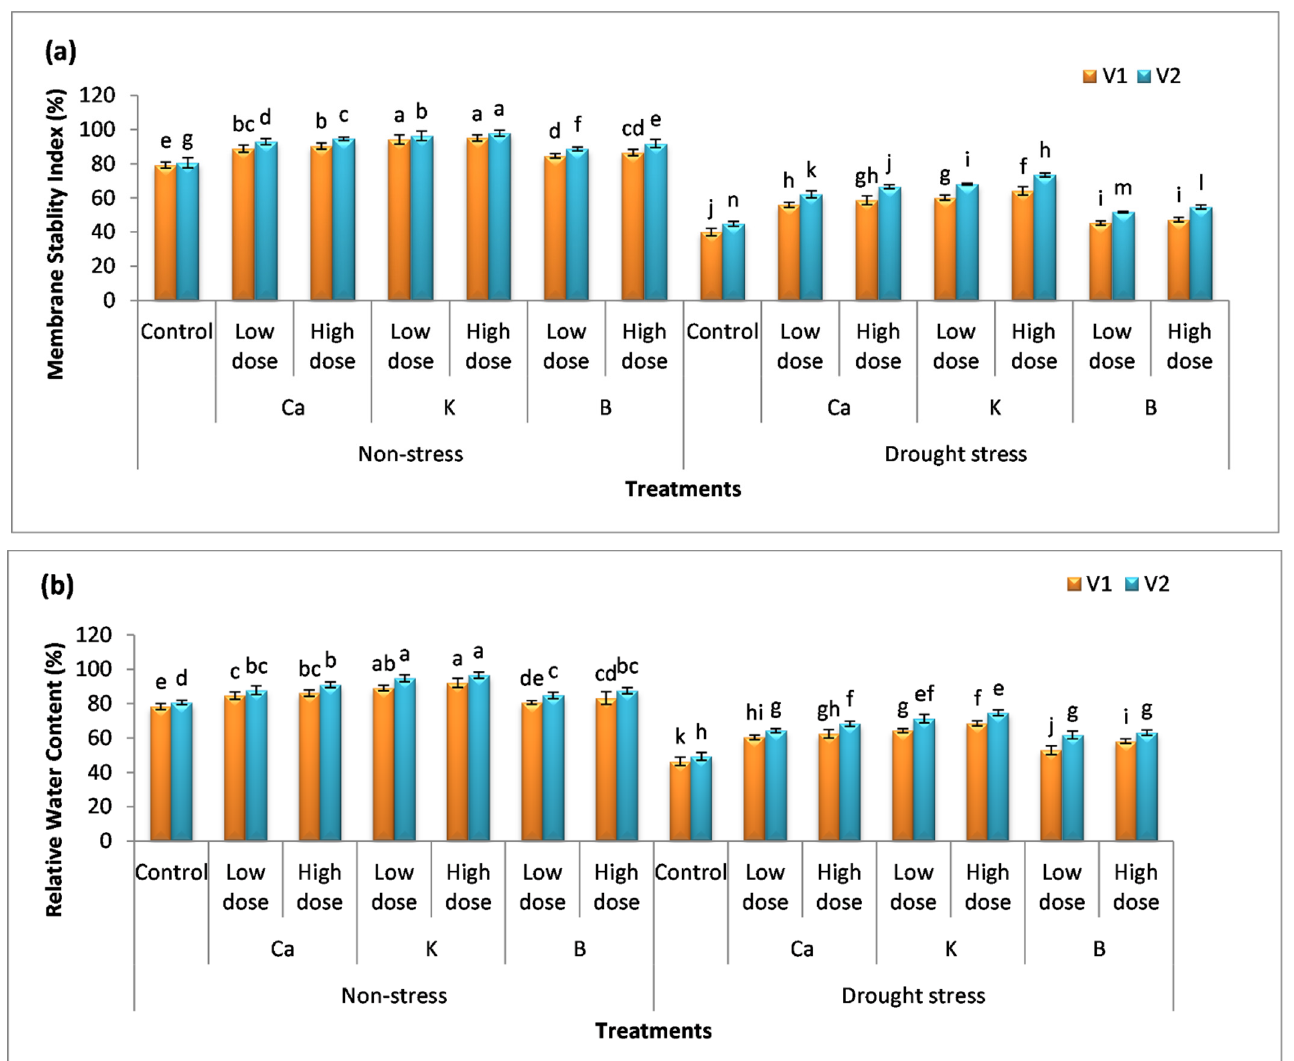
Figure 4. Effect of Ca, K, and B on the physiological attributes of durum wheat. ( a ) Membrane stability index and ( b ) relative water content of durum wheat, where V1 = Preco and V2 = Kronos. The different letter shows significant difference among the mean values of treatments.